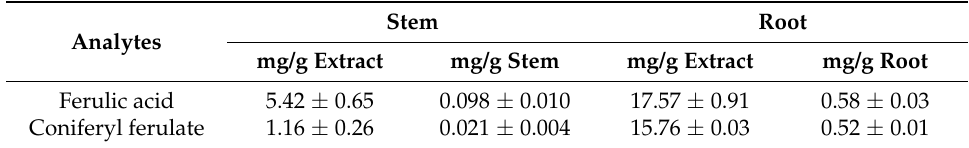
Figure 4. Mass Multiple Reaction Monitoring (MS–MRM) analysis of coniferyl ferulate (CA-FA) and ferulic acid (FA) in extracts of AS stem and root. Table 3. Contents of ferulic acid (FA) and coniferyl ferulate (CA-FA) analyzed by LC–MS/MS on MRM mode.